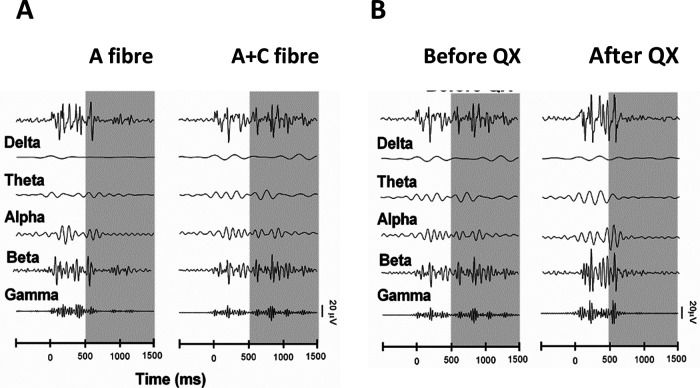
Sample raw traces of single EPs in P30 rat S1, following stimulation of the contralateral hindpaw, filtered to display the contribution from five frequency bands. A, Stimulation at A fiber strength (left) and A + C fiber strength (right). B, Stimulation before (left) and after QX-314 treatment (right).